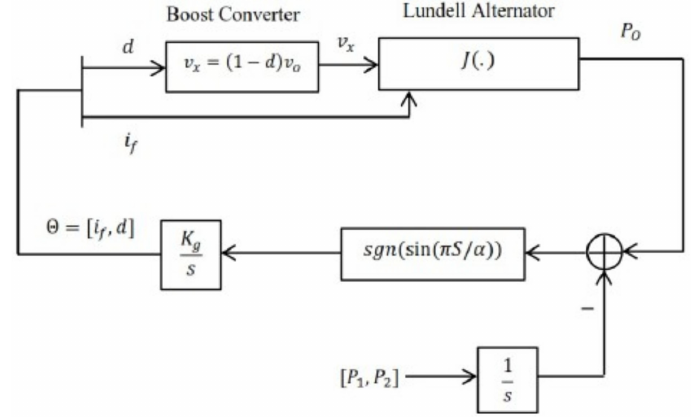
Figure 28. Proposed multivariable sliding mode ESC “Adapted with permission from